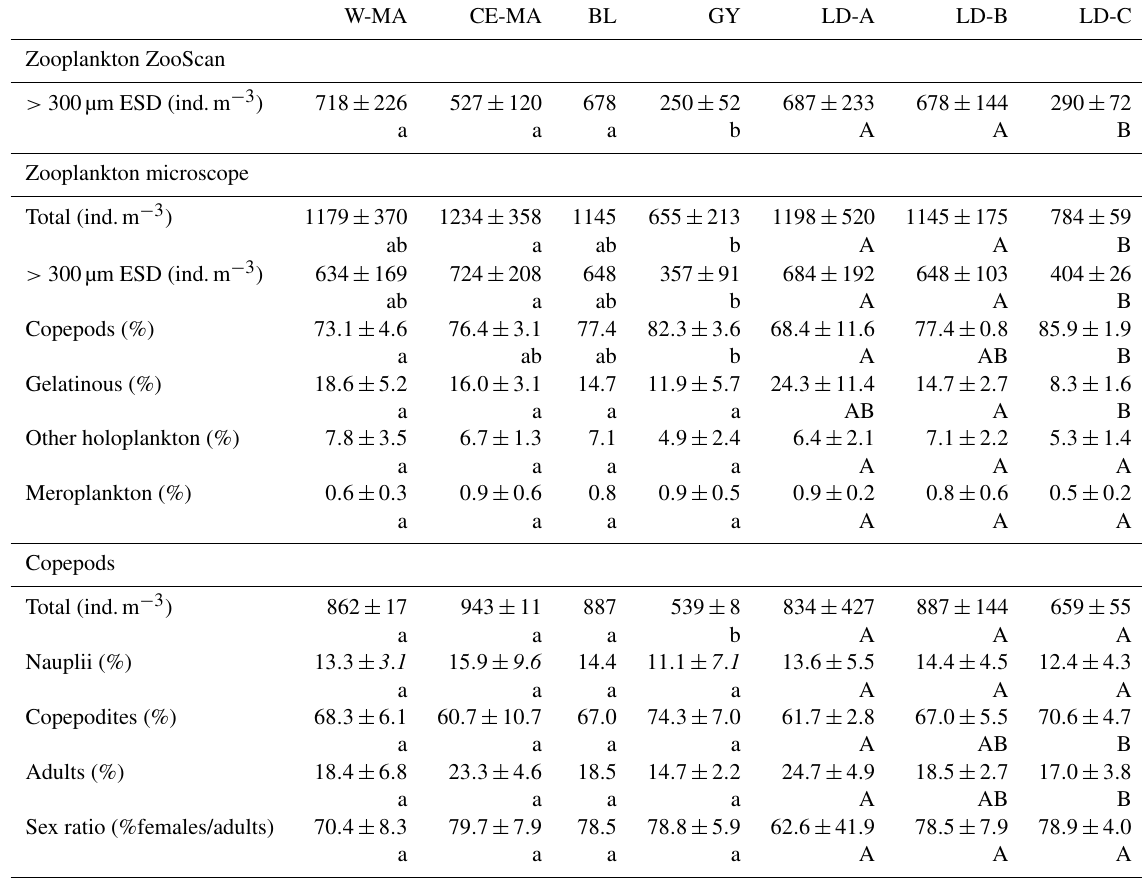
Table 2. Mean values ( ± standard deviation) of zooplankton abundances from ZooScan and microscopic counts, percentage of taxonomic groups, and total copepod demographic parameters at the stations for the four clusters defined in the PCA on environmental variables (see Fig. 2) and for the three long-duration stations. W-MA: western Melanesian archipelago; CE-MA: central and eastern Melanesian archipelago; BL: station B (blooming conditions); GY: subtropical gyre. Letters below the mean values indicate homogeneous groups